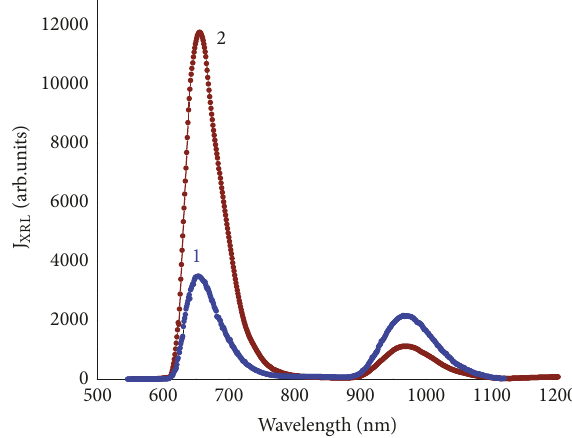
Figure 2: XRL spectra of the first (1) and the second (2) ZnSe samples at 85